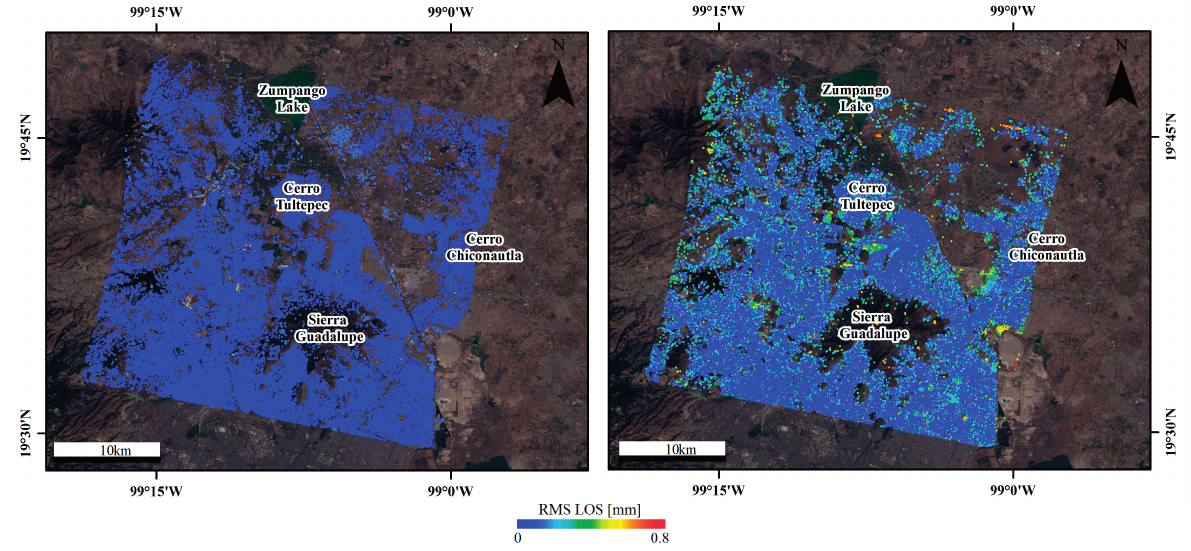
Figure 6. RMS system misclosure maps overlaying Landsat Imagery computed from the difference between the observed interferometric phase and the one reconstructed from the estimated phase delay by using: ( left ) ERS images, and ( right ) ENVISAT